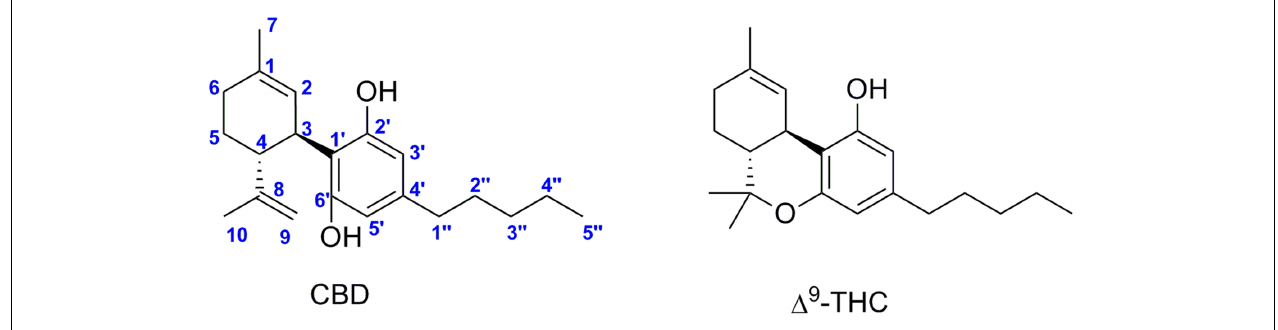
FIGURE 1 | Cannabidiol (CBD) and (–)- trans - (cid:49) 9 –tetrahydrocannabinol ( (cid:49) 9 –THC).